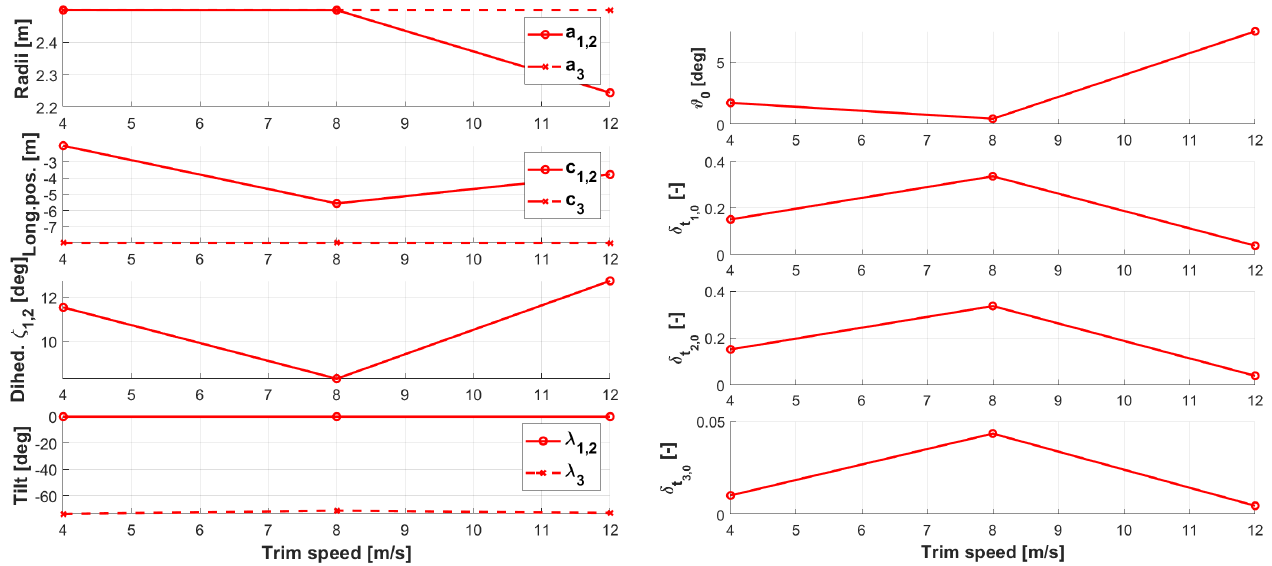
Figure 10. Optimal solutions ( left ) and trim results for optimizations at different airspeeds on layout (A).